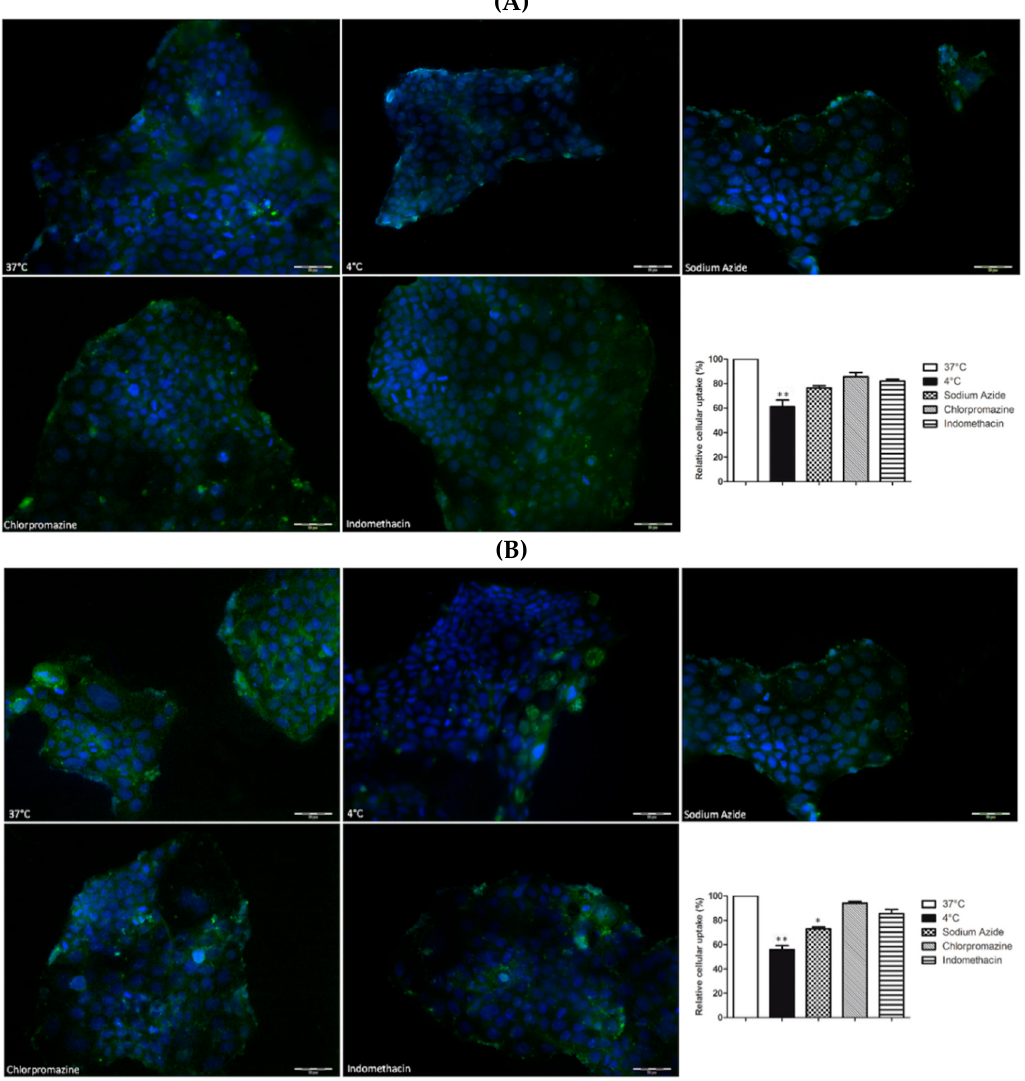
Figure 6. Cellular uptake of FITC-PNM ( A ) and FITC-MNM ( B ), green staining, in Caco-2 cells after 1 h of exposure at 37 °C (100%), at 4 °C or in the presence of endocytic inhibitors. Nuclei stained with DAPI. Final magnification 20×, scale bar 50 µm. Results are expressed as mean ± SEM, n = 3. ** p < 0.01 vs. 37 °C; * p < 0.05 vs. 37 °C, by Kruskal-Wallis test and Dunn’s multiple comparisons test.